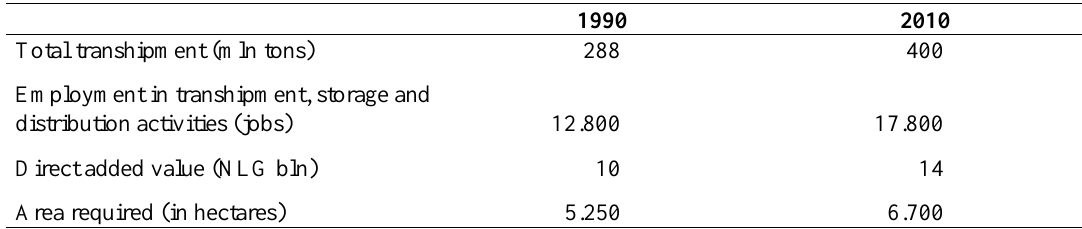
Table 9. Key figures of the 2010 Port Plan of